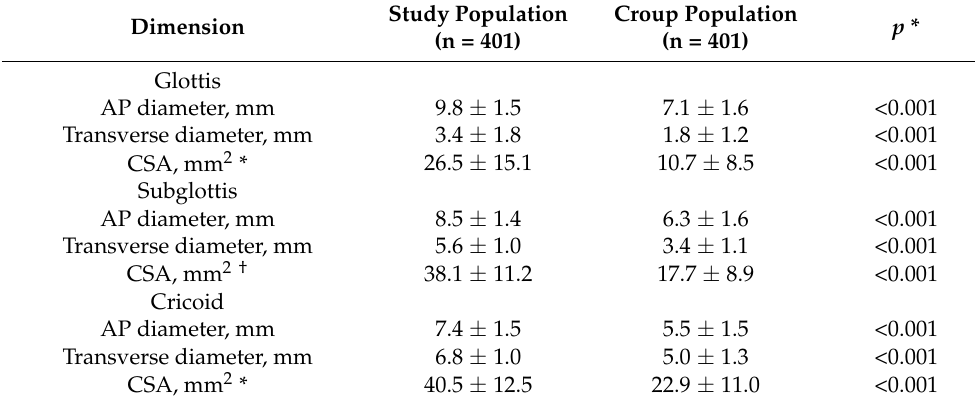
Table 2. Comparison with the age-matched croup population.